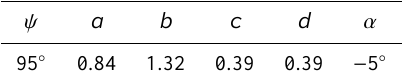
Table 2. Two-phalanx finger optimal geometric